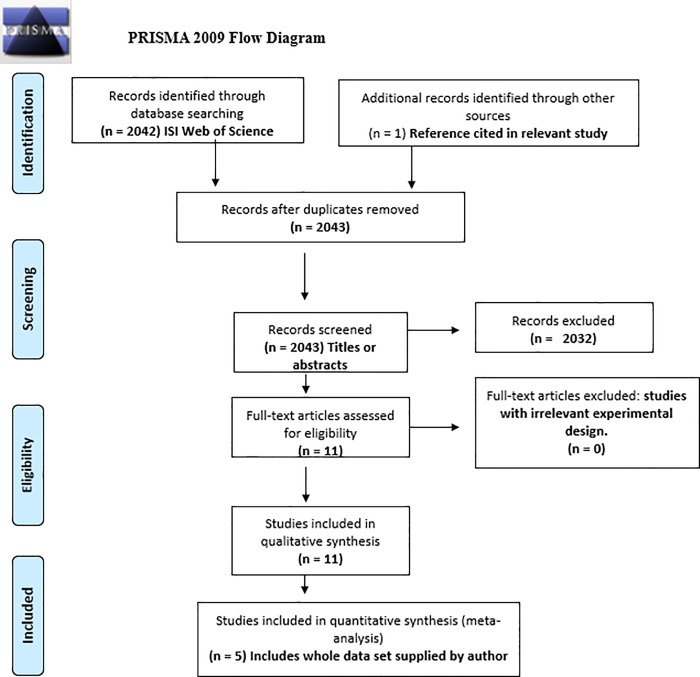
PRISMA flow diagram for study selection.From: Moher D, Liberati A, Tetzlaff J, Altman DG, The PRISMA Group (2009). Preferred Reporting Items for Systematic Reviews and Meta-Analyses: The PRISMA Statement. PLoS Med 6(7): e1000097. 10.1371/journal.pmed1000097. For more information, visit:
www.prisma-statement.org. [61].